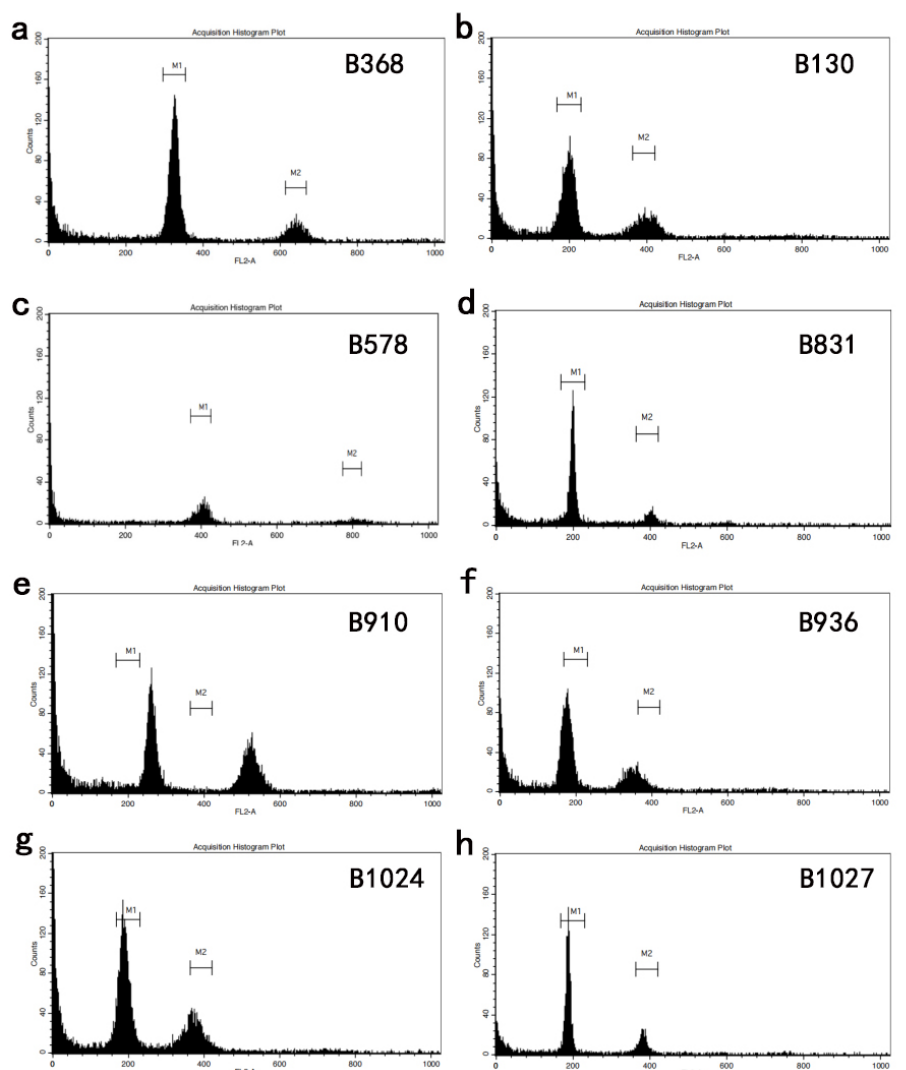
Figure 3. Detection of ploidy by flow cytometry. The letters ( a – h ) represented experimental materials of B368, B130, B578, B831, B910, B936, B1024, and B1027, respectively.